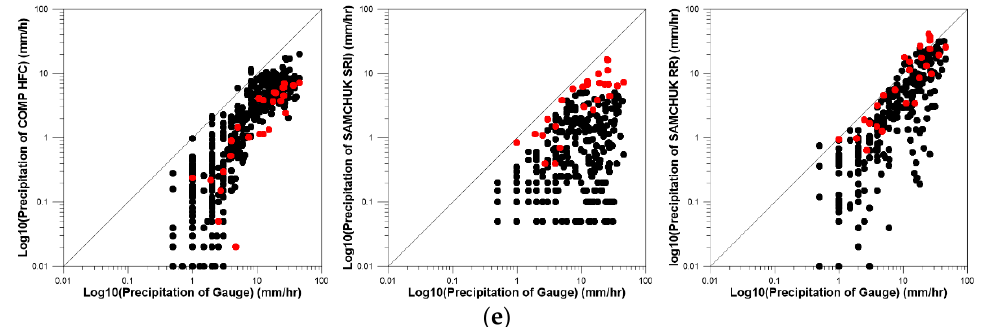
Figure 5. Scatterplots of observed ground rain gauge vs. various radar rainfall (red dots: rainfall in 10 km radius, black dots: rainfall in 40-km radius): ( a ) Event 1 (00:00–23:00 2–3 October 2019); ( b ) Event 2 (00:00–23:00 30 June 2020); ( c ) Event 3 (00:00–23:00 24 July 2020); ( d ) Event 4 (00:00–23:00 2–